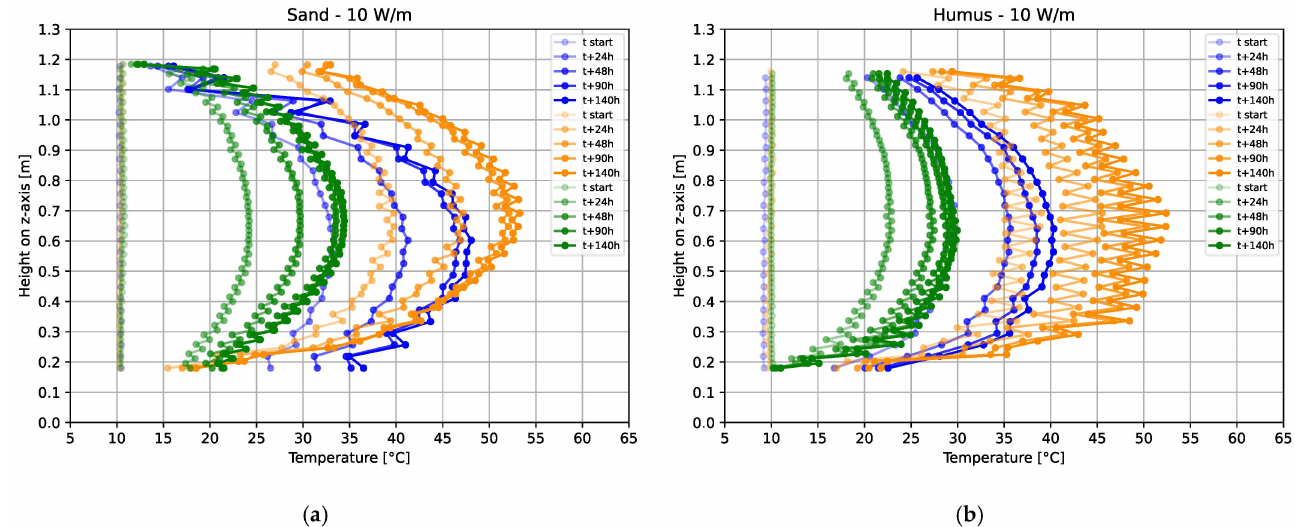
Figure 12. Temporal temperature profile over height in z-axis with sand ( a ) and soil ( b